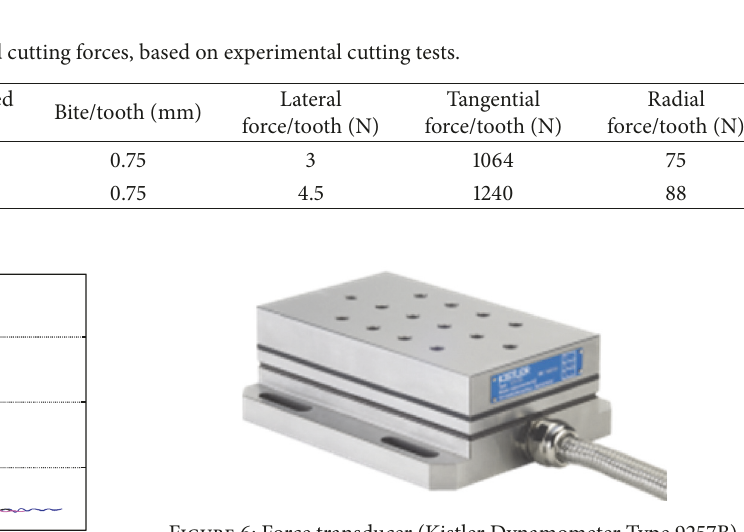
Figure 6: Force transducer (Kistler Dynamometer Type 9257B).